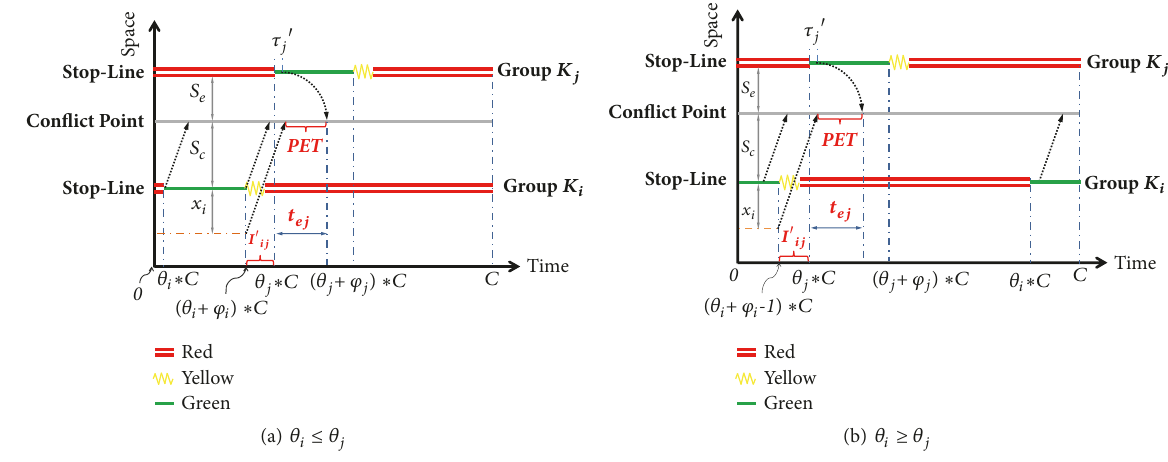
Figure 3: Definition of intergreen times between incompatible